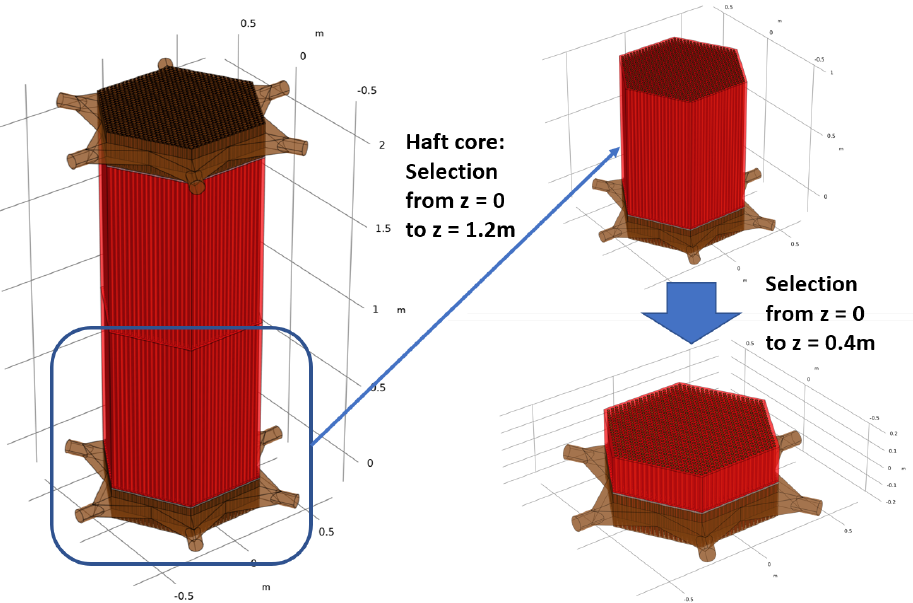
Figure 3. The arrangement of both fuel and coolant tubes in a real core: left, full height, z = 0 m to z =